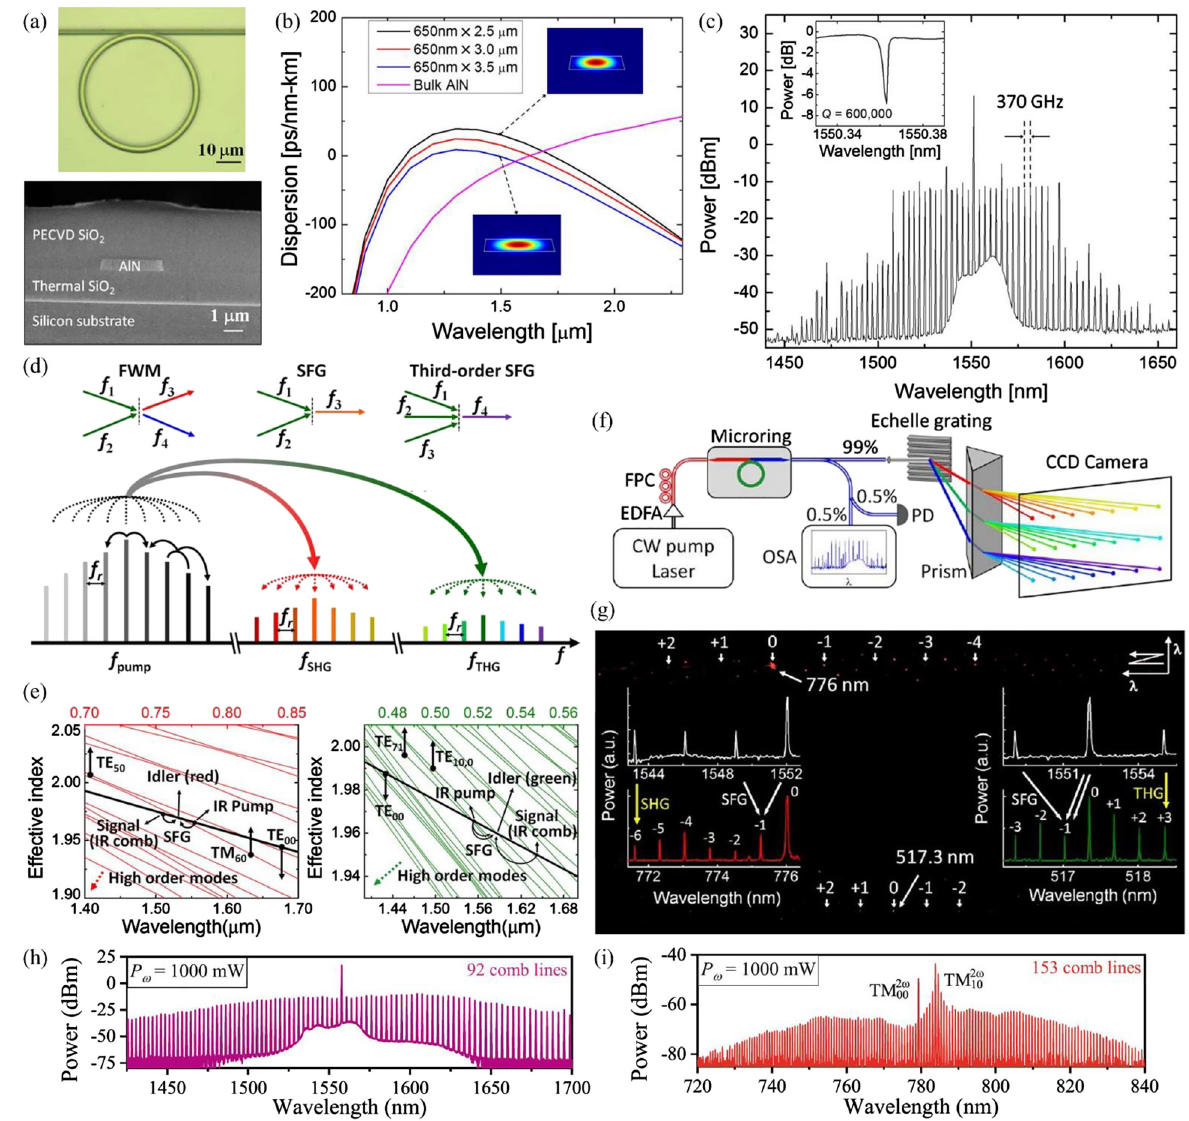
Figure 13: AlN-based integrated devices for χ (3) Kerr comb generation. (a) Top: microscopic image of microring resonator for Kerr comb generation. Bottom: cross sectional SEM image of AlN waveguide. (b) Dispersion relation of AlN waveguides fundamental TE mode under different waveguide width. Insets show the simulated mode intensity profiles at 1550 nm for waveguide width of 2.5 and 3.5 μ m. (c) Optical frequency comb generated by the fabricated microring resonator, spanning from 1450 to 1650 nm. Inset shows the transmission spectrum of resonance mode, with loaded Q value of 6 × 10 5 . (a) – (c) Adapted with permission from [178] © The Optical Society. (d) Principle of wide frequency comb generation, including the mechanisms of cascaded FWM for IR wavelength region, SHG and SFG for red color wavelength region, THG and third-order SFG for green color wavelength region. (e) Numericalsimulatedwaveguiderefractiveindexwithrespecttodifferentwavelengths.BlacksolidlineisforfundamentalTEmodeatIRaround 1550 nm. Red lines (left panel) represent different modes around 770 nm. Green lines (right panel) represent different modes around 520 nm. Phasematchingconditioncanbefoundatthecrossingpointsbetweenblacklineandred/greenline.(f)Schematicofsetupforfrequencycomb generation and characterization. FPC: fi ber polarization controller. (g) CCD camera image and extracted spectra with normalized power, plotted in red color (left inset) and green color (right inset). (d) – (g) Adapted with permission from [99] © The Optical Society. (h) Single crystalline AlN NIR optical frequencycomb spectrum, containing 92 comb lines. Note:comb is not fully shown, and there is a 7 dB attenuation to the spectrum to protect OSA from residual pump. (i) Near-visible frequency comb spectrum generated through SHG, showing 153 comb lines. (h) and (i) Adapted from [132], with the permission of AIP